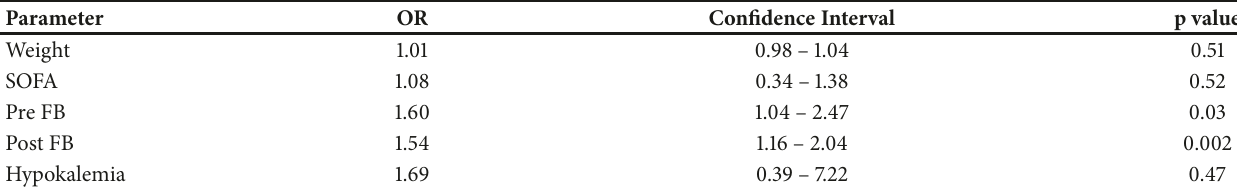
Table 6: Multivariate logistic regression of clinical and laboratory characteristics and dialysis complications associated with the death of patients with AKI treated with